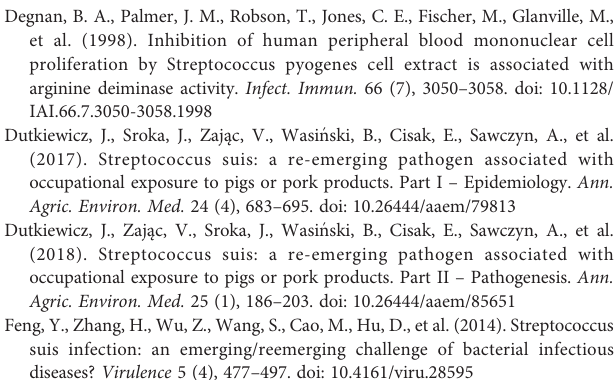
SUPPLEMENTARY FIGURE 1 | (A) PCR con fi rmation of the D gidA D mnmE mutant. Lanes 1 to 3 represent the ampli fi cation of the gidA gene using the primer set gidA -F/ gidA -R. Lanes4 to6 represent the ampli fi cation ofthe mnmE geneusing the primer set mnmE -F/ mnmE -R. Lanes 7 to 9 represent the ampli fi cation of the cps2J gene using the primer set cps2J -F/ cps2J -R. Lanes 1, 4, and 7 use DNA of SC19 as templates, whereas Lanes 2, 5, and 8 use DNA of D gidA D mnmE as templates, Lanes 3, 6, and 9 was negative control. (B) Con fi rmation of the D gidA D mnmE mutant by RT-PCR. Lanes 1 to 3 represent the ampli fi cation of